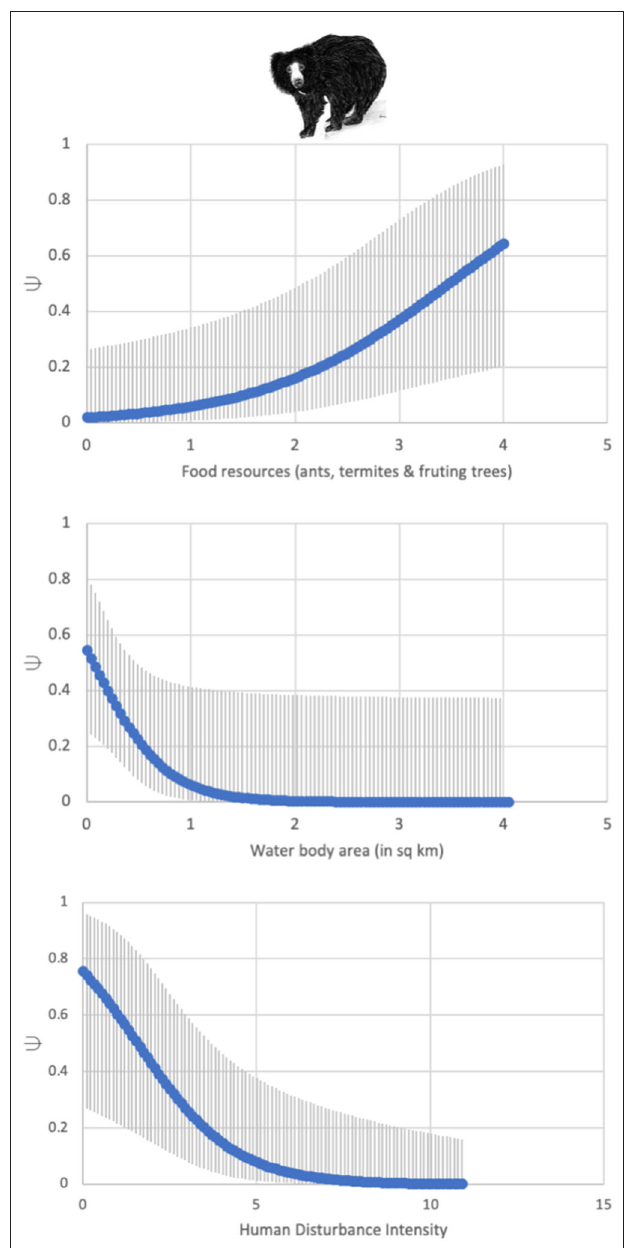
FIGURE 3 | Sloth bear occupancy increases with food resources (ants, termites, and fruiting trees), and water availability, but decreases with increasing human disturbance. Both food availability and human disturbance have a significant influence of sloth bear occupancy across these multi-use